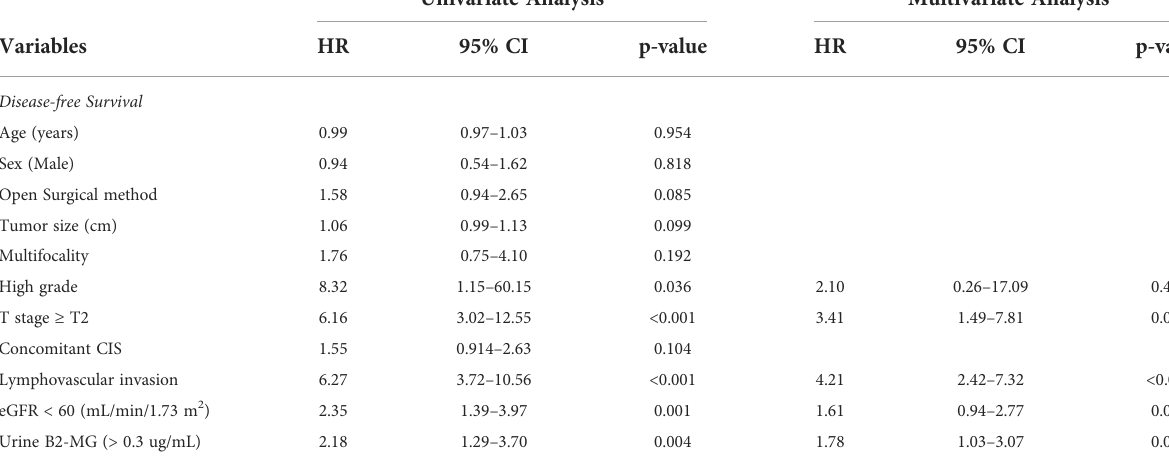
TABLE 5 Univariate and Multivariate Cox regression analysis of metastasis-free survival.